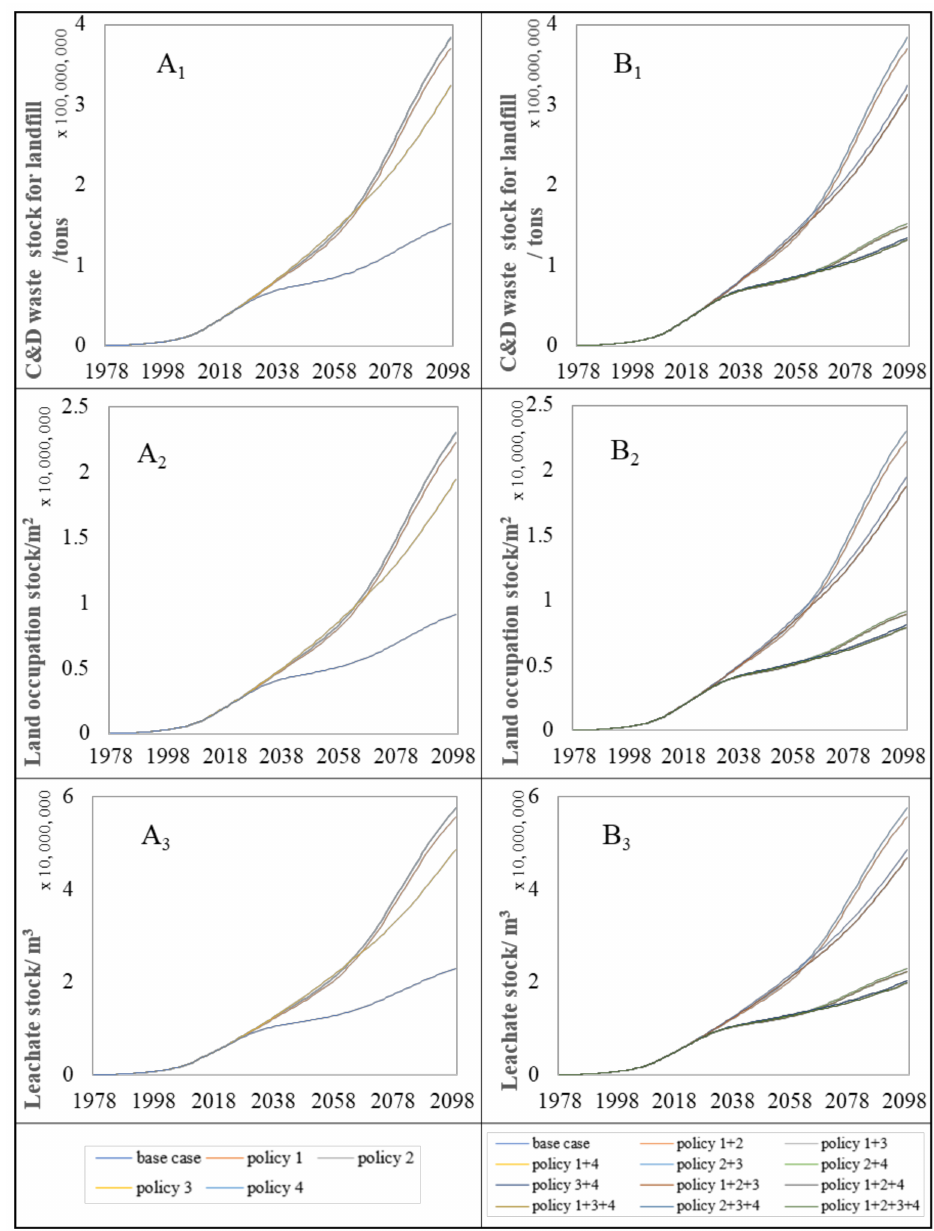
Figure 5. Trend of environmental impacts stock for proposed policy measures. A 1 and B 1 represent the trend associated with environmental impacts stock of C&D waste for landfill under single policy and complex policy, respectively. A 2 and B 2 are the trend associated with environmental impacts stock of land occupation under single policy and complex policy, respectively. A 3 and B 3 indicate the trend associated with environmental impacts stock of leachate under single policy and complex policy,